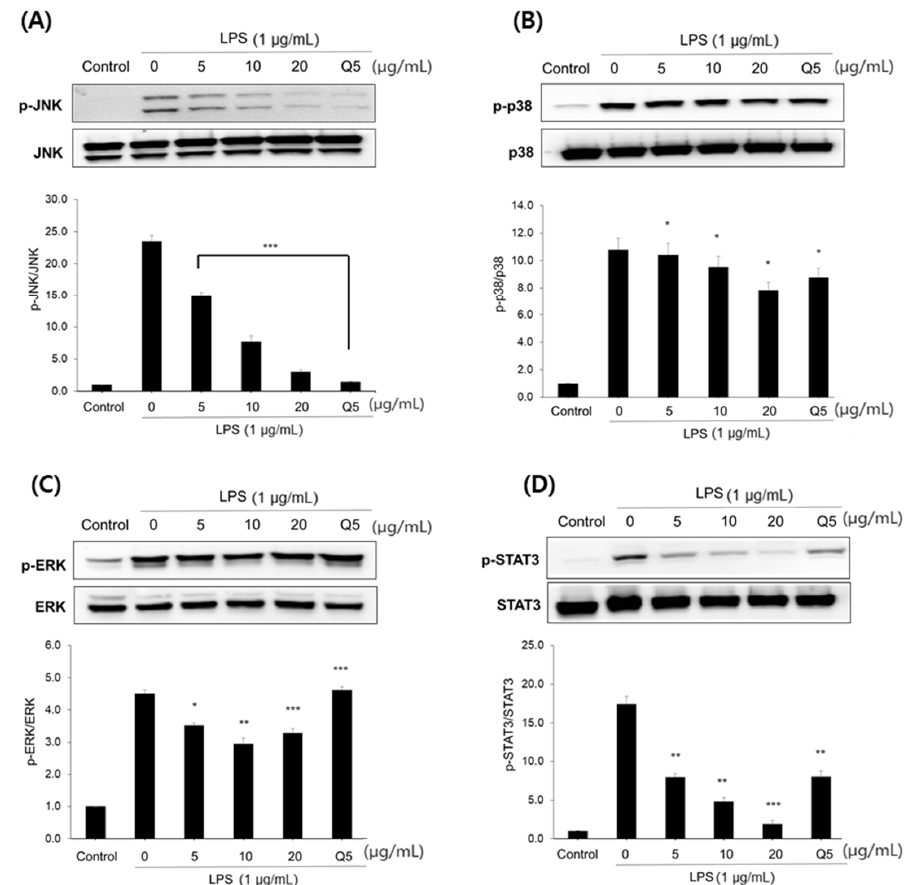
Figure 5. Effect of compound 1 on the phosphorylation of MAPK, ( A ) JNK, ( B ) p38, ( C ) ERK and ( D ) STAT3 in RAW 264.7 cells. All data are presented as the mean ± SEM ( n = 3). Quercetin (Q5, 5 µ g/mL) was used as the positive control. * p < 0.05 and ** p < 0.01, *** p < 0.001 indicate significant differences compared to the LPS control group.